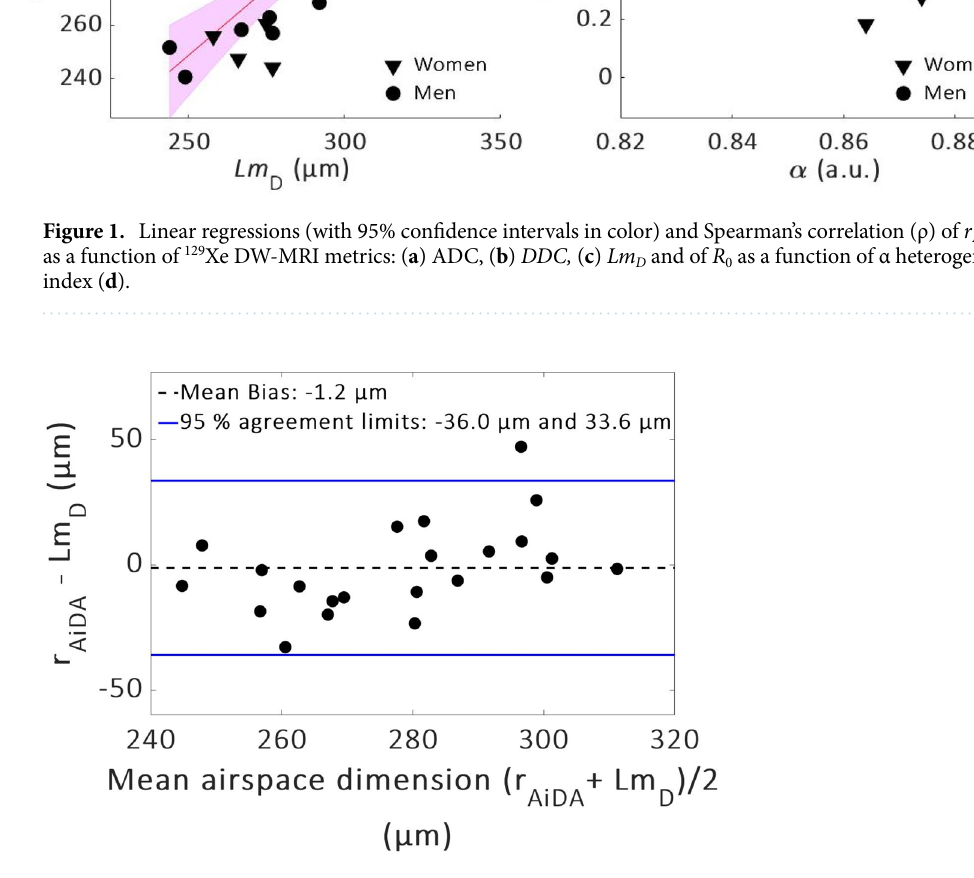
Figure 2. Bland–Altman plot of distal airspace radius r AiDA and mean diffusive length scale Lm D . A mean bias of 1.2 µm towards r AiDA and 95% agreement limits − 36.0 to 33.6 µm were